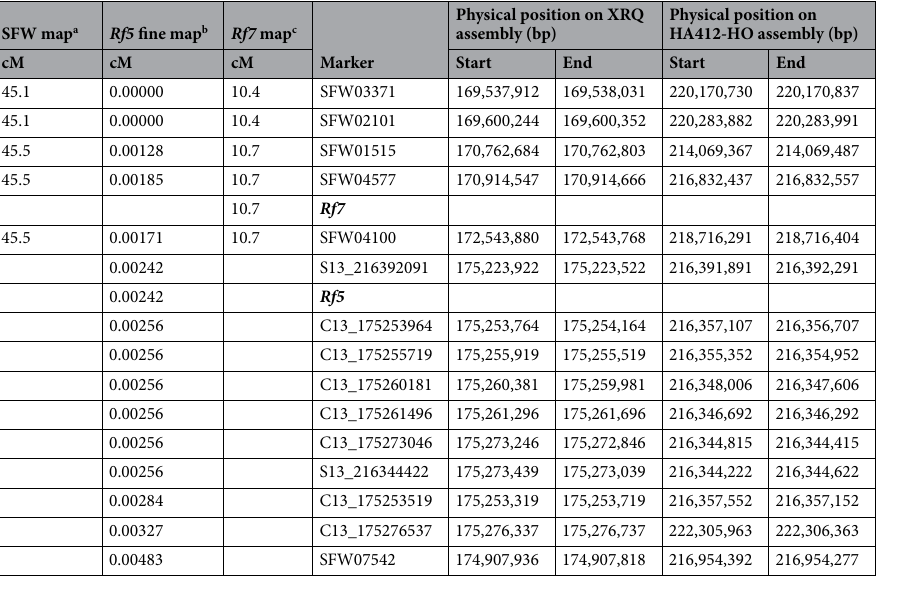
Table 7. Genetic and physical positions of markers linked to Rf5 and Rf7 on chromosome 13. a Markers taken from Bowers et al. (2012) 67 , b markers taken from present study, and c markers taken from Talukder et al. (2019) 8